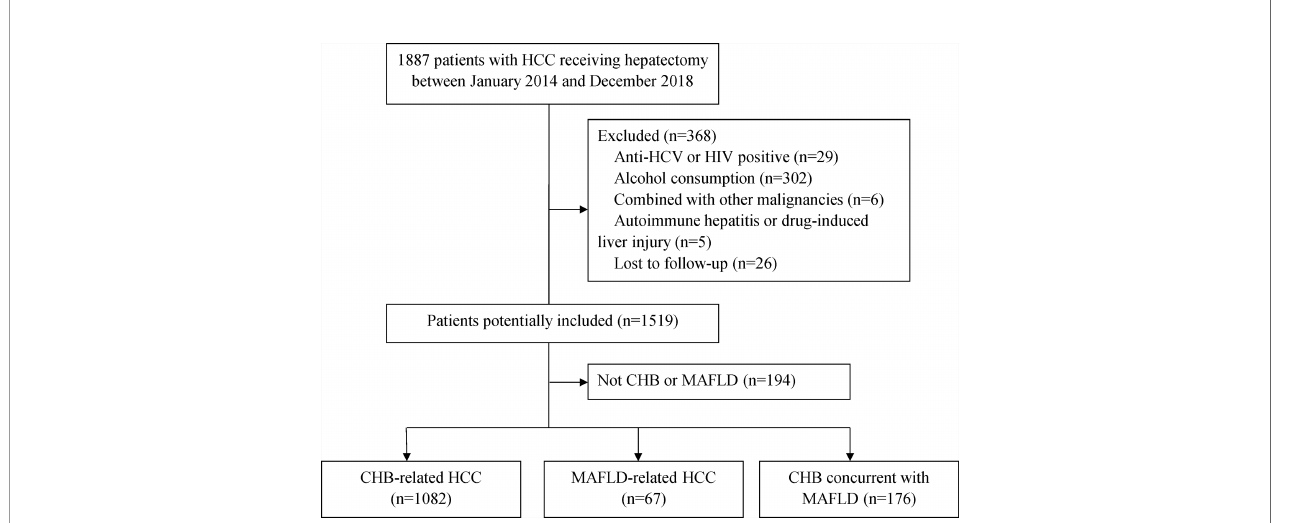
FIGURE 1 | Patient selection fl ow. CHB, chronic hepatitis B; HCC, hepatocellular carcinoma; HCV, hepatitis C virus; HIV, human immunode fi ciency virus; MAFLD, metabolic dysfunction-associated fatty liver